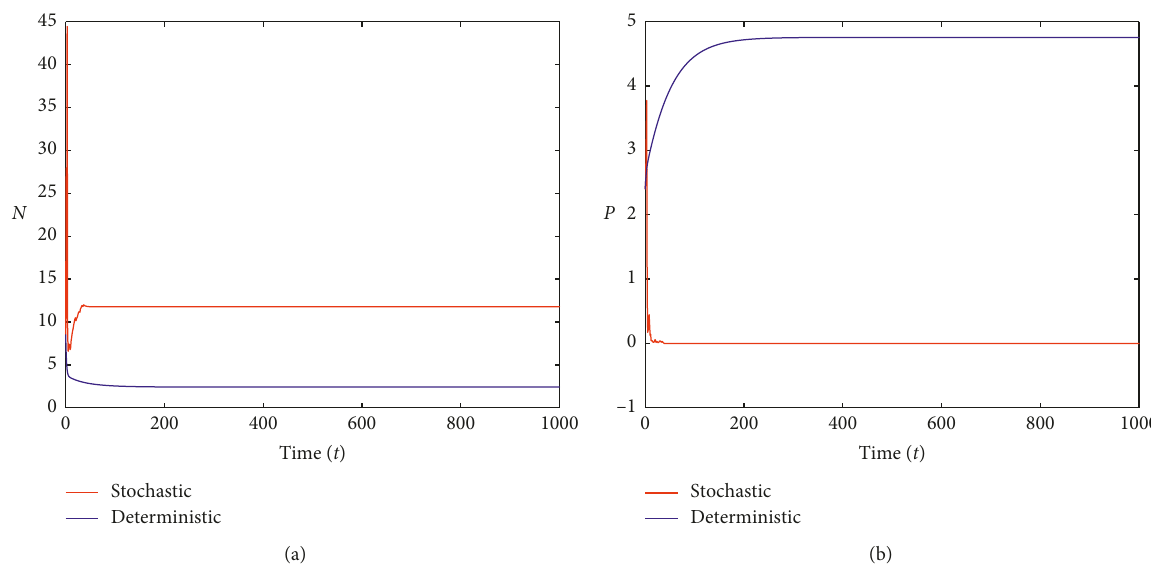
Figure 5: The solutions of the stochastic model (3) and its corresponding deterministic model (1) with initial value ( N For the nutrient. (b) For the